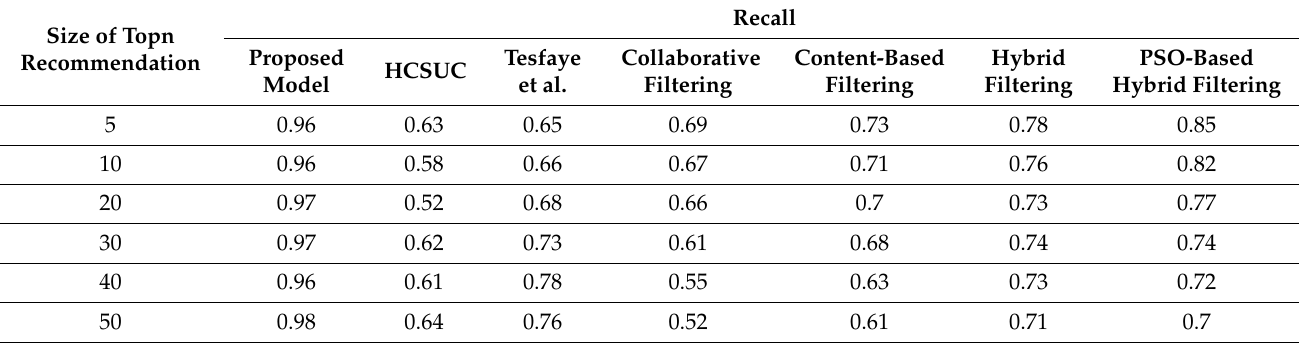
Table 9. Recall according to the Topn Recommendation (Considering Dataset 2 [44]).